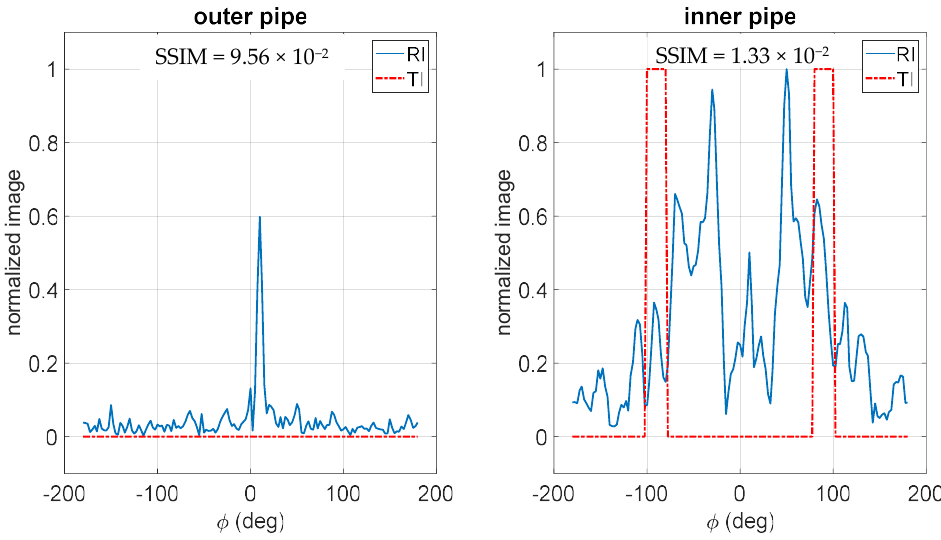
Figure 6. Reconstructed images with an added standoff distance of 2 mm (RI: reconstructed image and TI: true image).